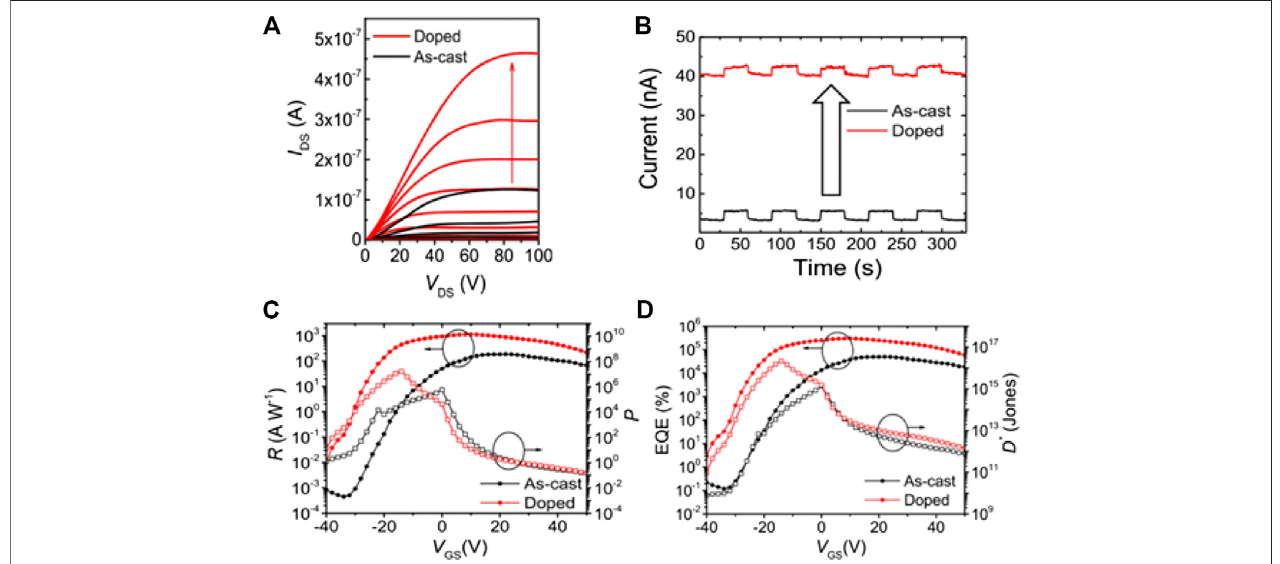
FIGURE 9 | (A) Output characteristics of an ( R )-CLCPDI-Ph-CF single crystal before and after hydrazine doping, (B) photo-switching curve of as-cast (undoped) anddoped( R )-CLCPDI-Ph-CFsingle-crystalOPTs, (C) photoresponsivity( R )andphotosensitivity( p ),and (D) EQE anddetectivity( D* )ofOPTsbasedonan( R )-C1CPDI- Ph-CF single crystal and hydrazine-doped ( R )-C1CPDI-Ph-CF single crystal, respectively. Reproduced with permission (Shang et al., 2020). Copyright 2020, American Chemical Society.